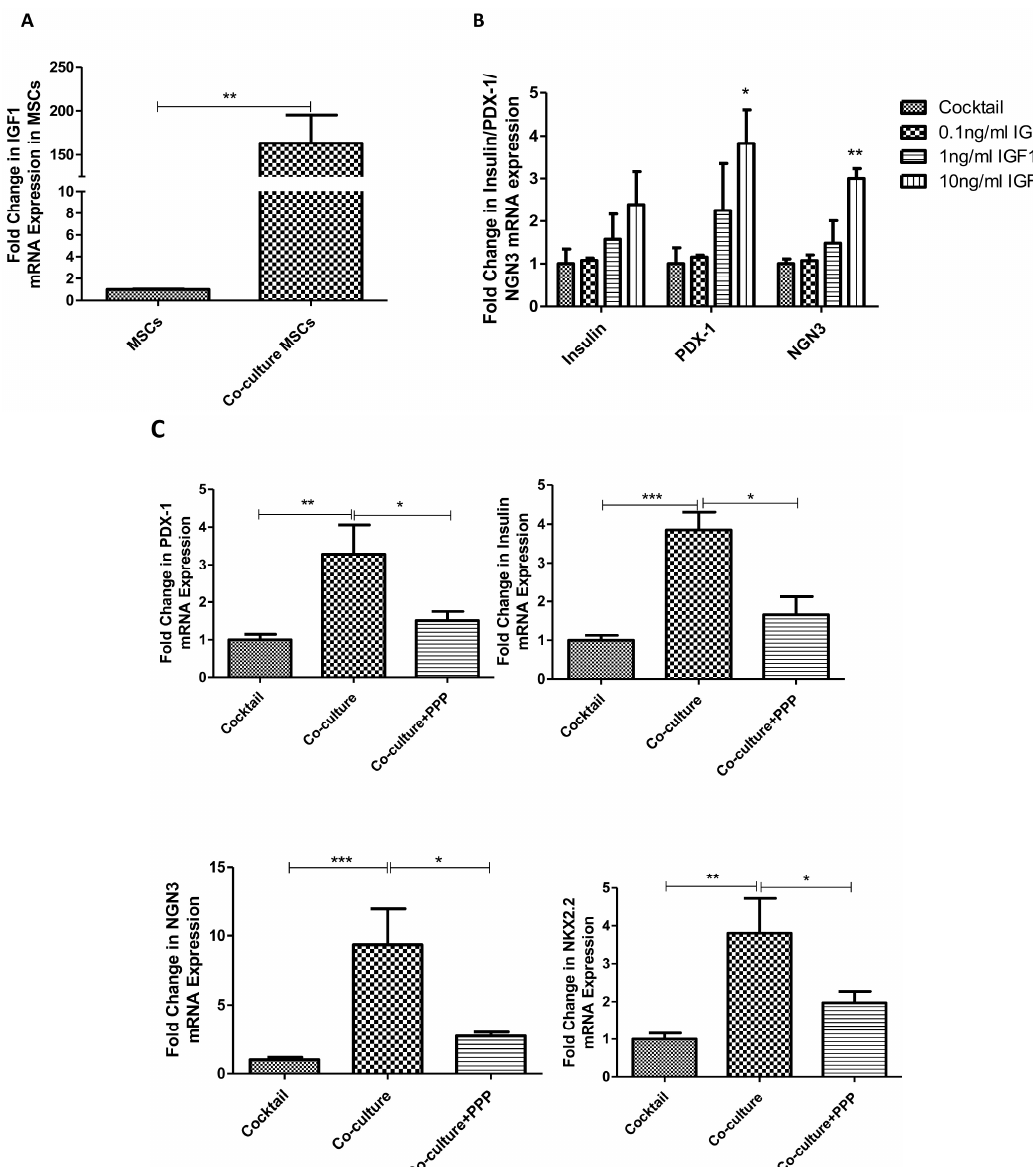
Figure 6. Involvement of IGF1 in the MSC-mediated PPC di ff erentiation into ICCs. ( A ) IGF1 gene expression was elevated after co-culture as demonstrated by real-time PCR. The e ff ects of IGF1 ( B ) and IGF1R ( C ) on the di ff erentiation of PPCs were demonstrated by the expression profile of di ff erentiation and maturation markers using real-time PCR. (n = 3 per group; * p < 0.05, ** p < 0.01, *** p < 0.001. All data are expressed as means ± SEM).